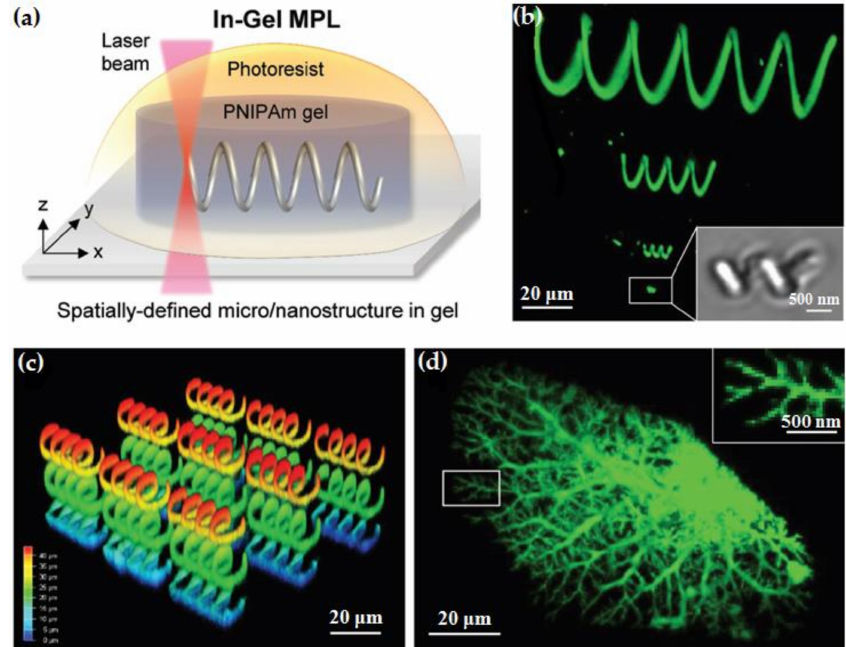
Figure 24. ( a ) Schematic diagram of spiral structure in hydrogel by DLW; The 3D-reconstructed CLSM image of ( b , c ) Spiral model structures; and ( d ) blood vessel model structure